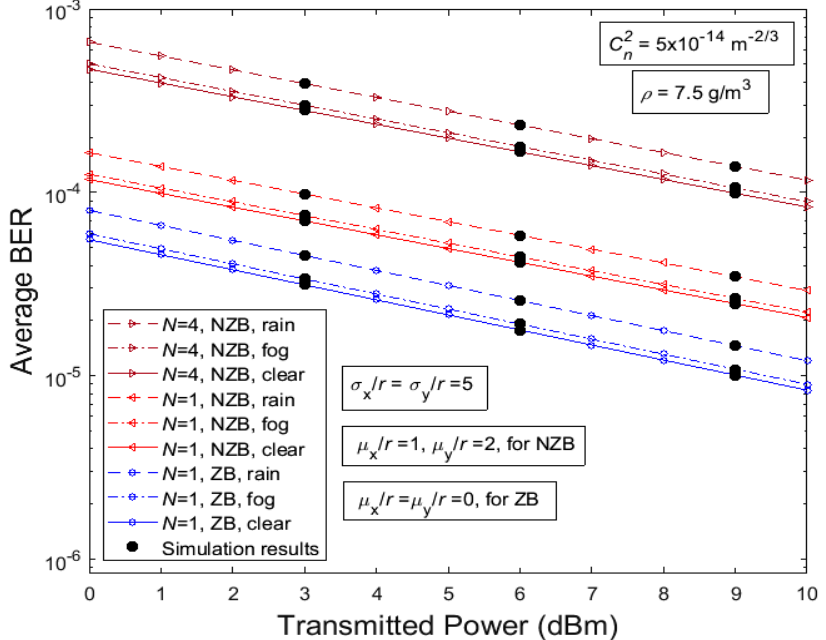
Figure 2. ABER vs. transmitted power for single-hop and quad-hop THz link configurations under different weather conditions, weak turbulence, FSPL, moderate water vapor concentration and weak generalized pointing errors.